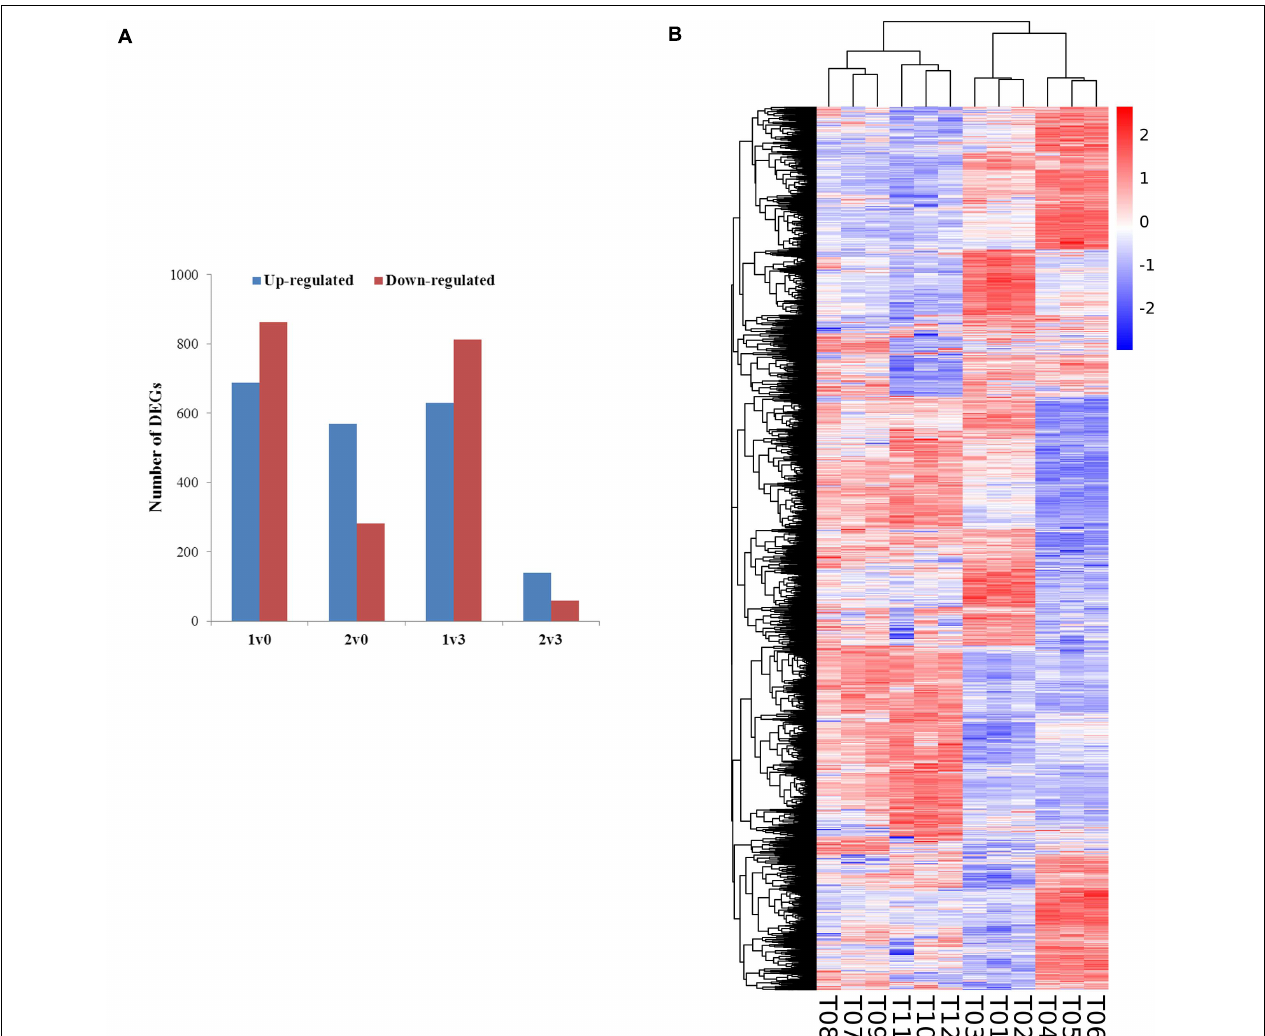
FIGURE 2 | Gene expression profiles of faba bean buds. (A) Numbers of DEGs in pairwise comparisons of the four treatments. (B) Heatmap diagrams showed the relative expression levels of DEGs among the four